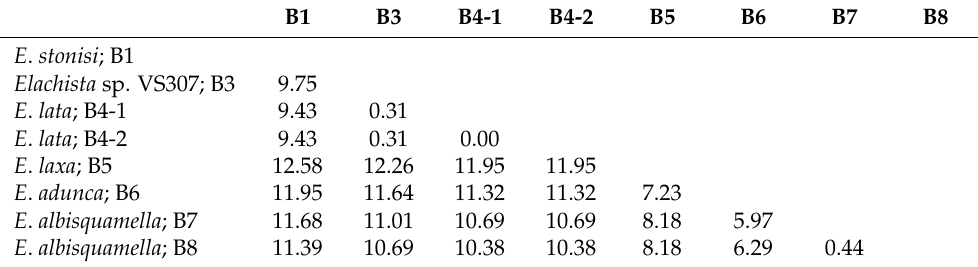
Table 3. Uncorrected pairwise p-distances (%) between partial sequences of mitochondrial cy- tochrome oxidase subunit I (COI) from samples of 6 species of Neotropical species of Elachista praelineata species group.